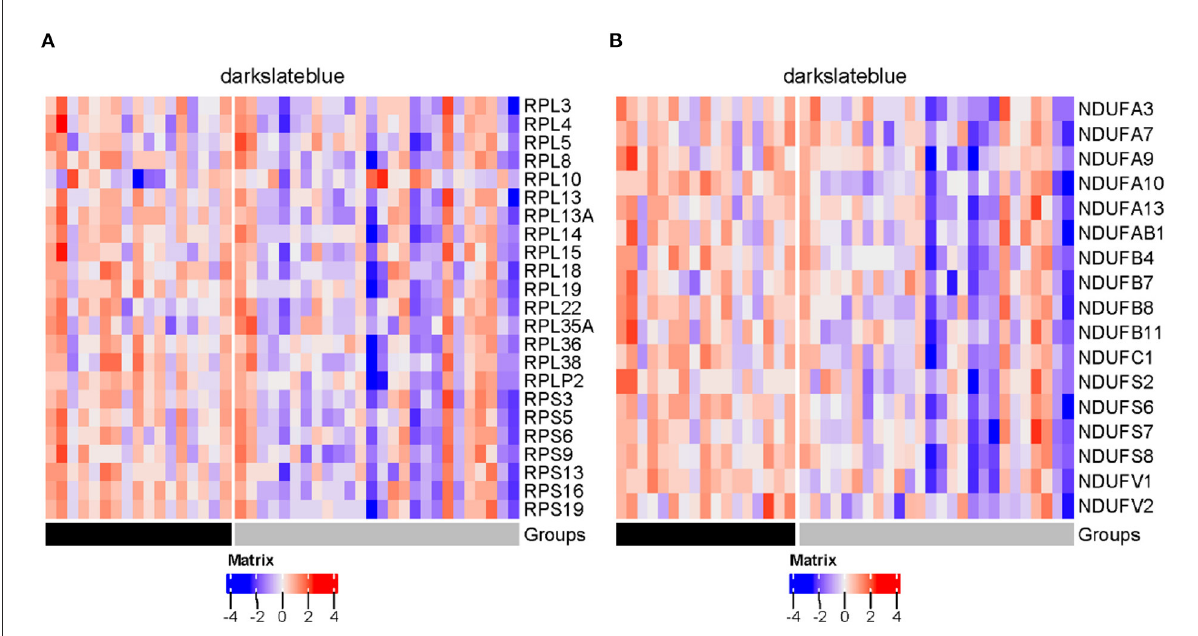
FIGURE14 Heatmaps of genes encoding ribosomal proteins (A) and mitochondrial complex I subunits (B) in darkslateblue module (gray = SI; black =